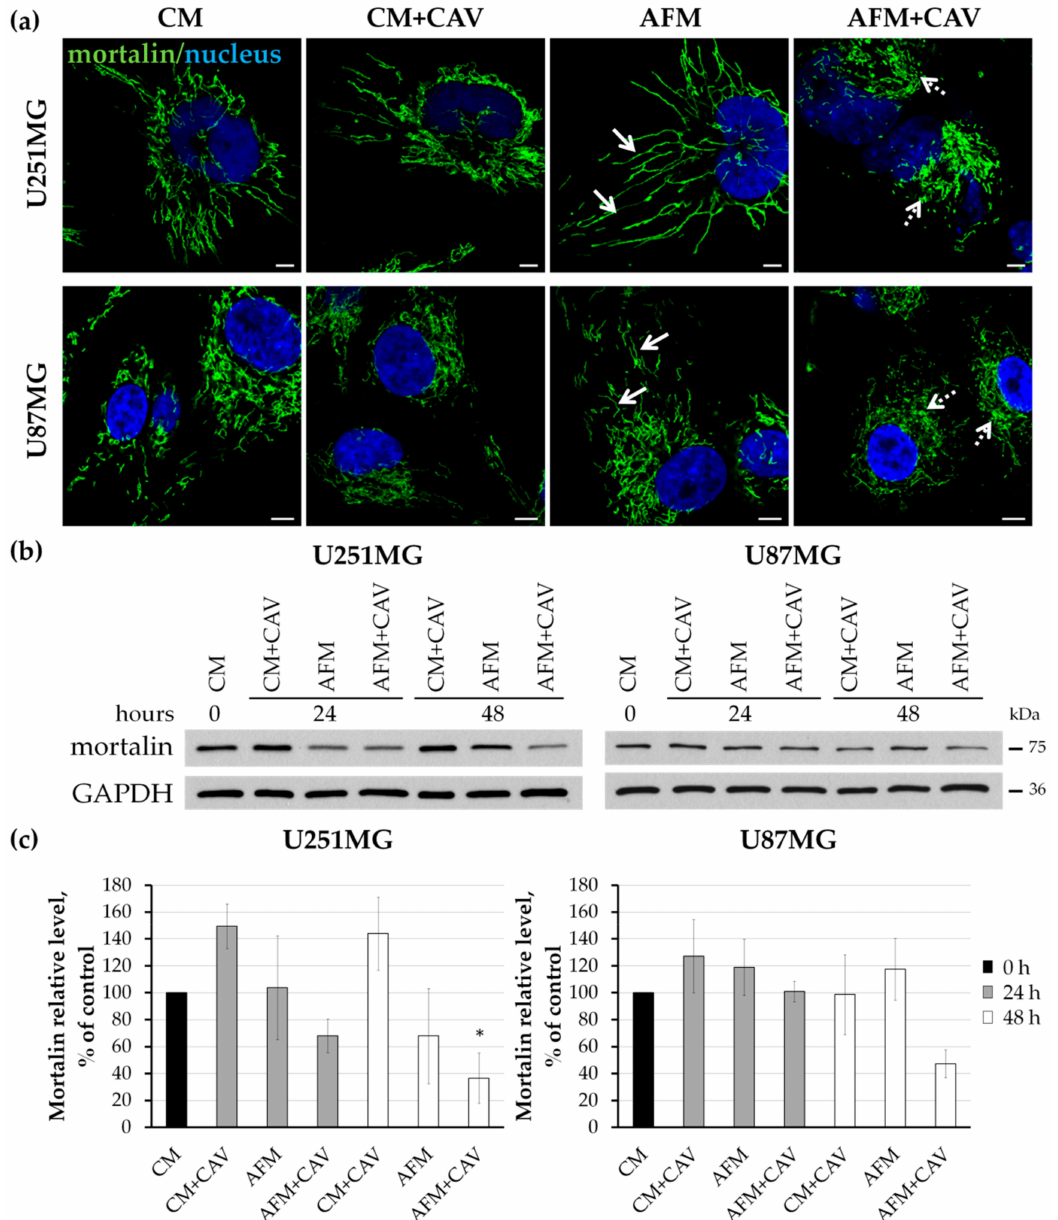
Figure 11. Assessment of mitochondrial organization in human U251MG and U87MG glioblastoma cells treated with 50 µ M canavanine under CM and AFM conditions. ( a ) Immunostaining for mortalin. Nuclei were labeled with DAPI. Cells were treated for 48 h under experimental conditions. Bars, 5 µ m. Arrows indicate hyperconnected mitochondria, and dotted arrows point to aggregate-like mitochondria. ( b ) Western blot analysis of mortalin levels. GAPDH was used as a protein loading control. ( c ) Densitometry of mortalin protein levels. Graphs represent mean values ± SD from three independent experiments. * p < 0.05 relative to CM (control,